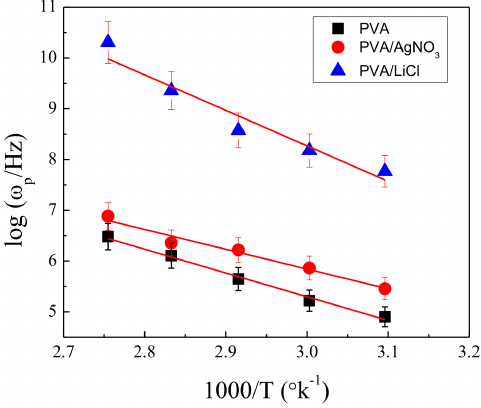
Figure 7. The log ω h vs. 1000/ T for PVA, PVA/LiCl film and PVA/AgNO 3